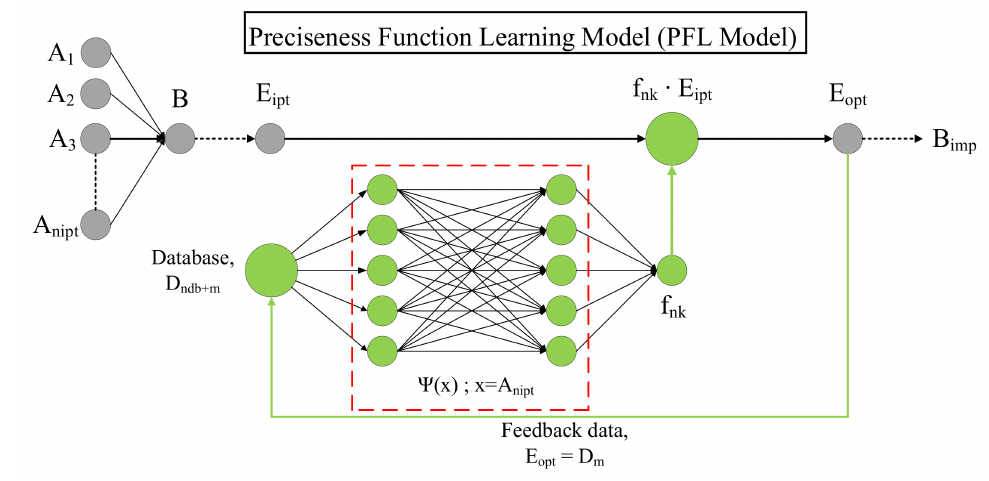
Figure 7. Structure of the Preciseness Function Learning Model (PFL